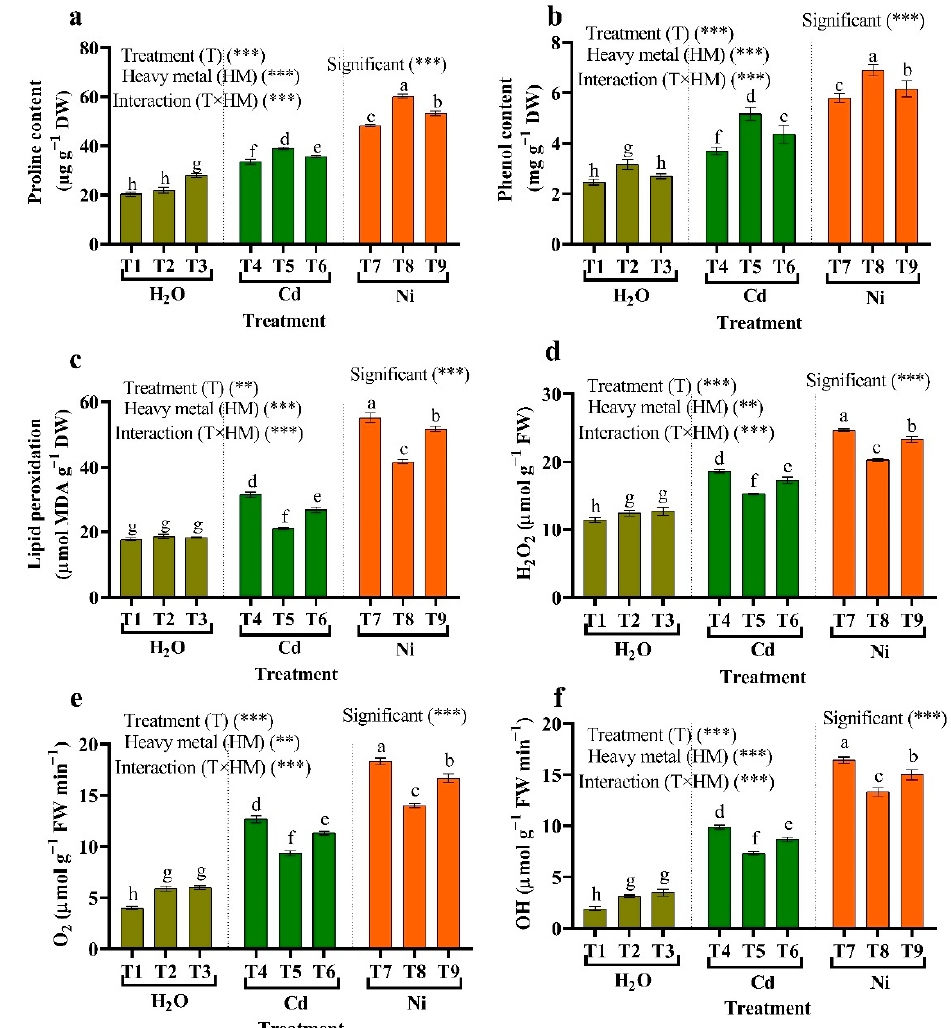
Figure 5. The influence of two different endophytic bacteria on ( a ) proline, ( b ) phenol, ( c ) lipid peroxidation (MDA), ( d ) hydrogen peroxide (H 2 O 2 ), ( e ) hydroxyl radicals (OH), and ( f ) superoxide anion (O 2 ) in tomato plants growing under HM stress. Fisher’s test at p < 0.05 reveals significant variations in means ( ± standard error) of different letters (a–h) on the same bars. Thus, ** and *** imply significance levels of 0.01 and 0.05, respectively. T1: (Control with tap water), T2: Micrococcus luteus , T3: Enterobacter cloacae , T4: 50 µ M Cd, T5: Micrococcus luteus + 50 µ M Cd, T6 : Enterobacter cloacae + 50 µ M Cd T7: 50 µ M Ni, T8: Micrococcus luteus + 50 µ M Ni, T9 : Enterobacter cloacae + 50 µ M